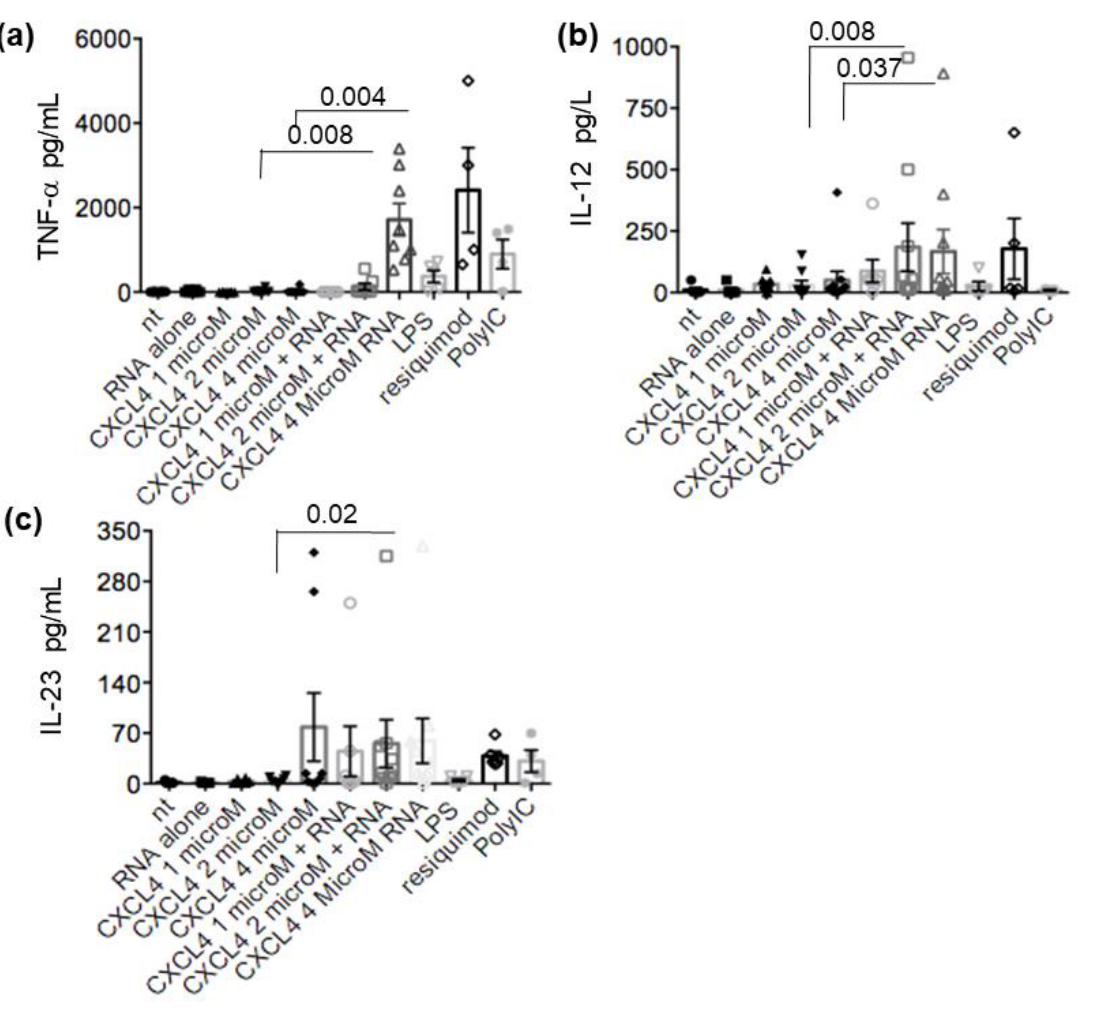
Figure 4. MDDCs are stimulated to produce pro-inflammatory cytokines by CXCL4-RNA complexes. MDDCs were either untreated (nt) or treated with RNA alone or CXCL4 alone or with different amounts of CXCL4-RNA complexes ( b , c ) or with TLR agonists. Production of cytokines, TNF- α ( a ), IL-12 ( b ), and IL-23 ( c ) was evaluated by ELISA on culture supernatants harvested after 48 h. ( a – c ) Results from 3 to 8 experiments (depending on the stimulation) performed with the MDDCs of different donors. P -values were by Mann –Whitney’s test.